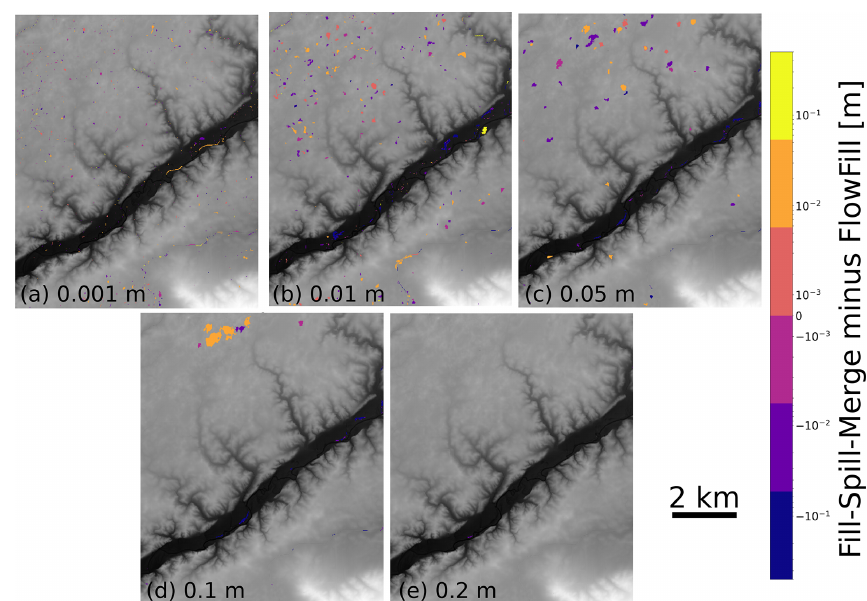
Figure 7. The difference between results of Fill–Spill–Merge and FlowFill at the Sangamon River site. The values for panels (a) to (e) indicate the depth of uniform runoff applied across the landscape for both algorithms. For example, in (a) , each cell across the domain starts with 0.001m of surface water. Orange to yellow indicates locations where Fill–Spill–Merge had more water, and purple to blue indicates locations where FlowFill had more water. Differences of less than 3mm have been masked out. Differences are generally small and are likely a result of the iterative nature of the FlowFill algorithm, which causes it to asymptotically approach the correct values. In some locations, Fill–Spill–Merge retains slightly more water in depressions than FlowFill does. This could be due to water that has not yet finished moving downslope and into these depressions in the FlowFill algorithm. In other locations, FlowFill has retained more water. One possible reason for this is that some depressions have a narrow outlet through which Fill–Spill–Merge is able to move all water as appropriate, but the cell-by-cell movement of water with FlowFill can produce transient dams that reroute additional water towards these subcatchments. This DEM was prepared by Lai and Anders (2018) and Callaghan and Wickert (2019) from lidar topographic data provided by the Illinois State Geological Survey (Illinois Geospatial Data Clearinghouse, 2020).